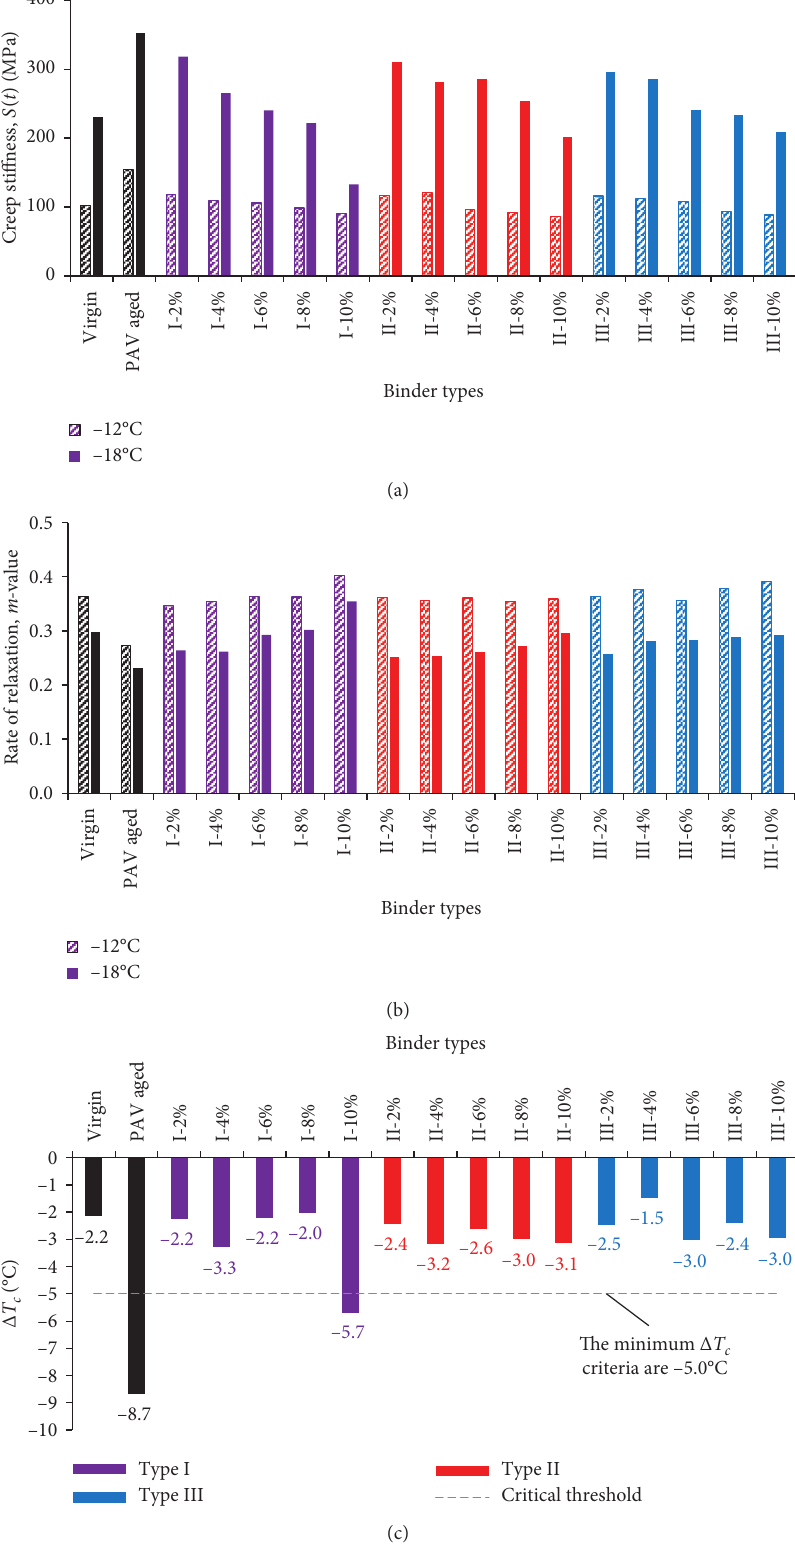
Figure 5: Effects of the types and dosages of rejuvenators on (a) creep stiffness ( S ( t )); (b) rate of relaxation ( m -value); (c) difference of BBR creep or m critical temperature, delta T c ( Δ T c